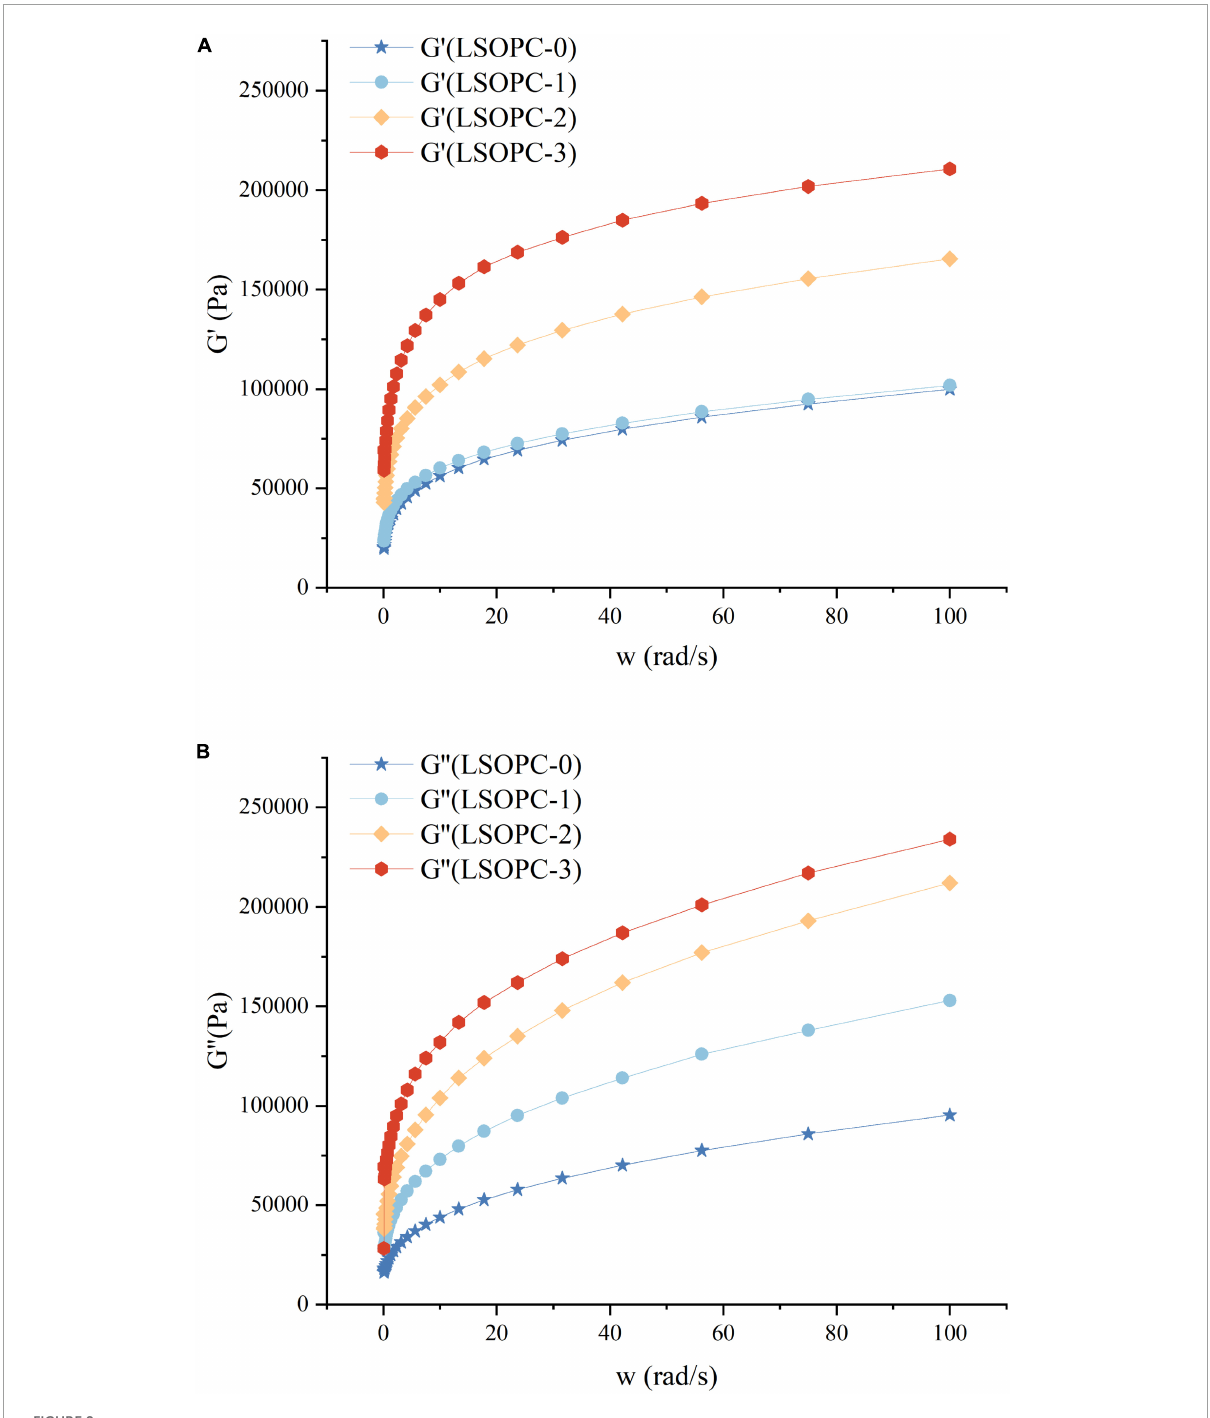
FIGURE8 Effect of LSOPC on G’ (A) and G” (B) .